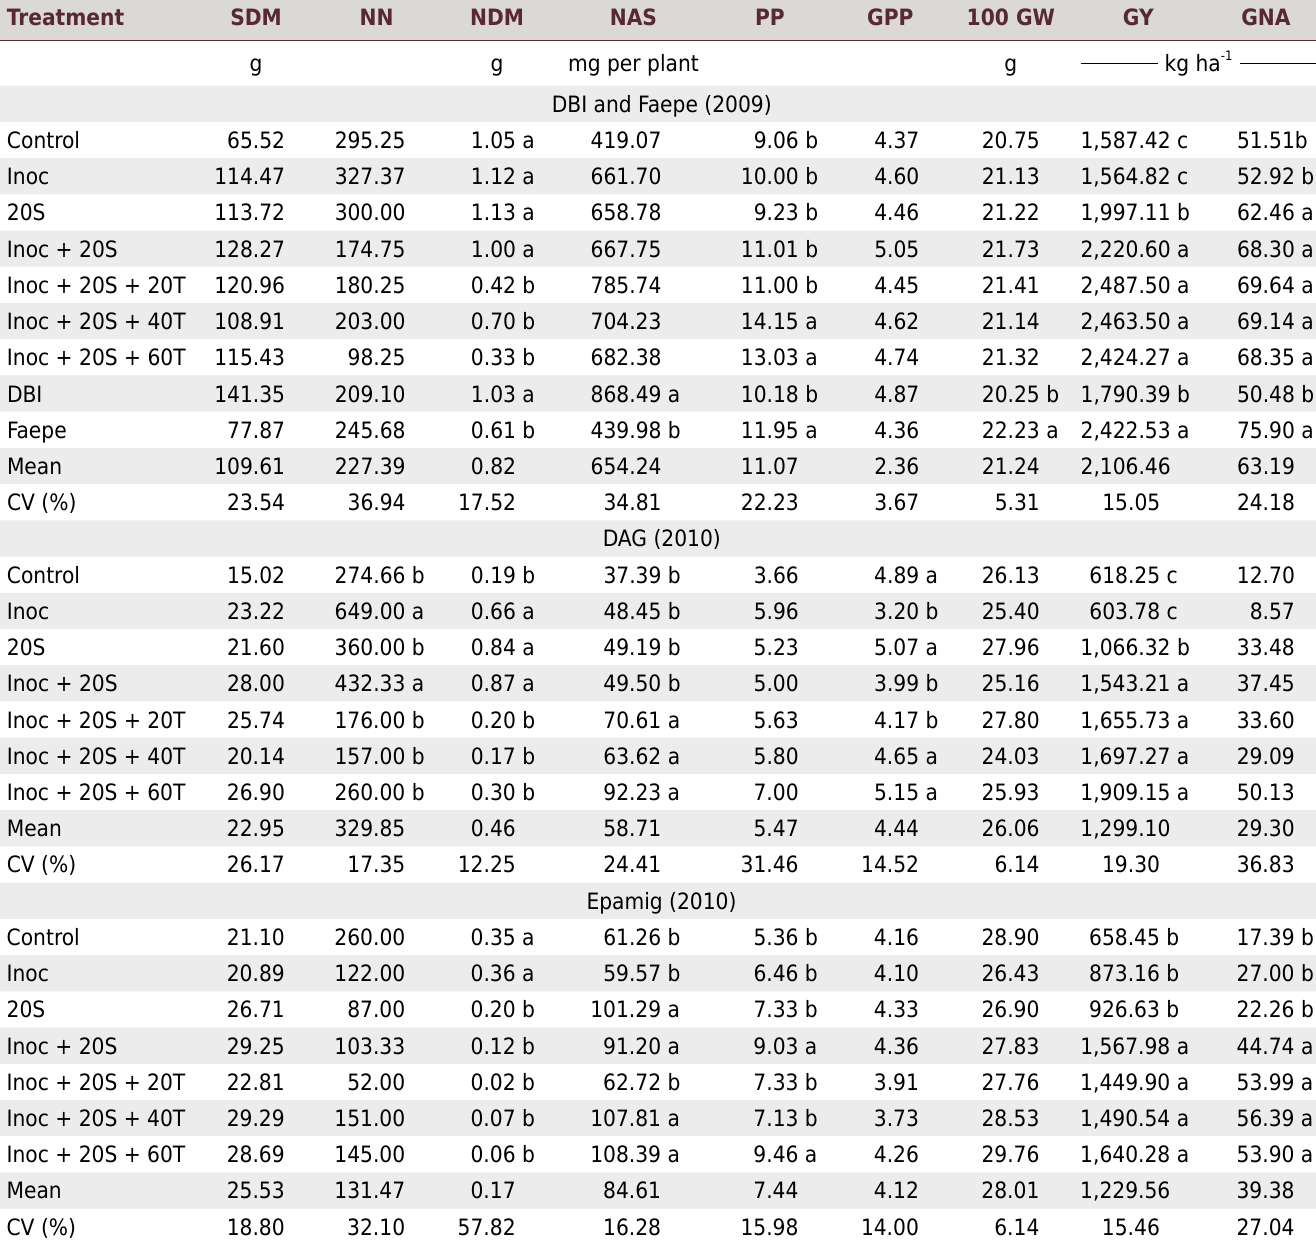
Table 4. Mean values for shoot dry matter (SDM), number of nodules (NN), nodule dry matter (NDM), nitrogen accumulation in shoots (NAS), pods per plant (PP), grains per pod (GPP), hundred grain weight (100 GW), grain yield (GY), and grain nitrogen accumulation (GNA), with and without inoculation of common bean, with different nitrogen fertilization rates at DBI and Faepe in 2009, DAG in 2010, and Epamig in 2010 during the flowering period and harvest Treatment